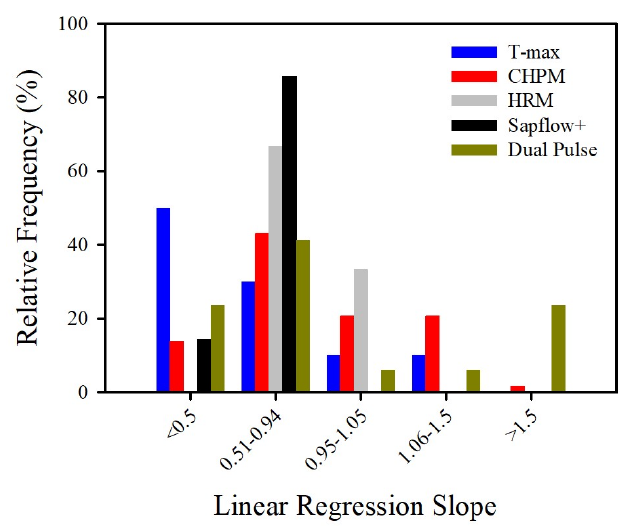
Figure 1. A relative frequency histogram of the slope of the regression curve from the studies compiled in the meta ‐ analysis (Supplementary Materials). For easier comparison, slopes were grouped into different ranges where <0.5 indicates severe underestimation, 0.51 to 0.94 indicates moderate underestimation, 0.95 to 1.05 indicates good accuracy, 1.06 to 1.5 indicates moderate overestimation, and a slope >1.5 indicates severe overestimation of the HPV method for actual plant water use.